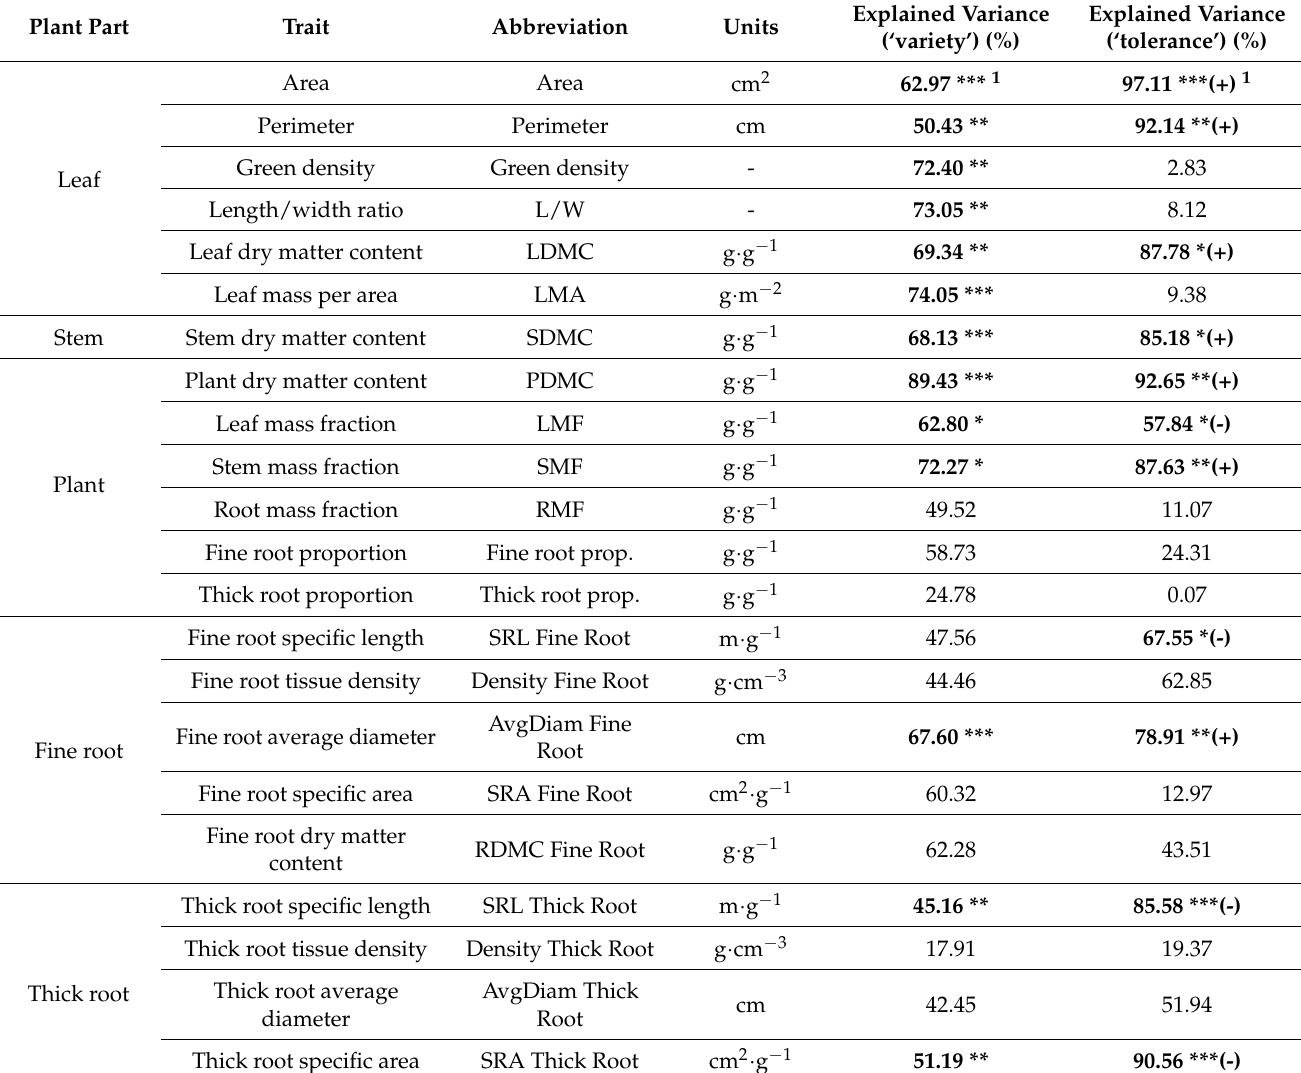
Table 1. Results of ANOVA analyses for different plant traits using ‘variety’ or ‘tolerance’ as factors. Plant Part Trait Abbreviation Units